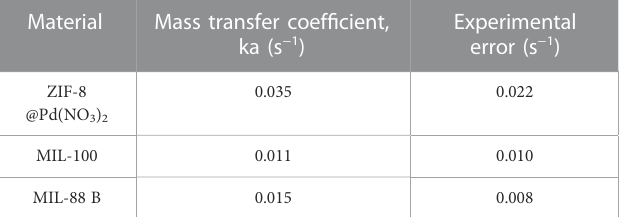
TABLE 3 Catalyst mass transfer coef fi cients for LA calculated by ZLC.